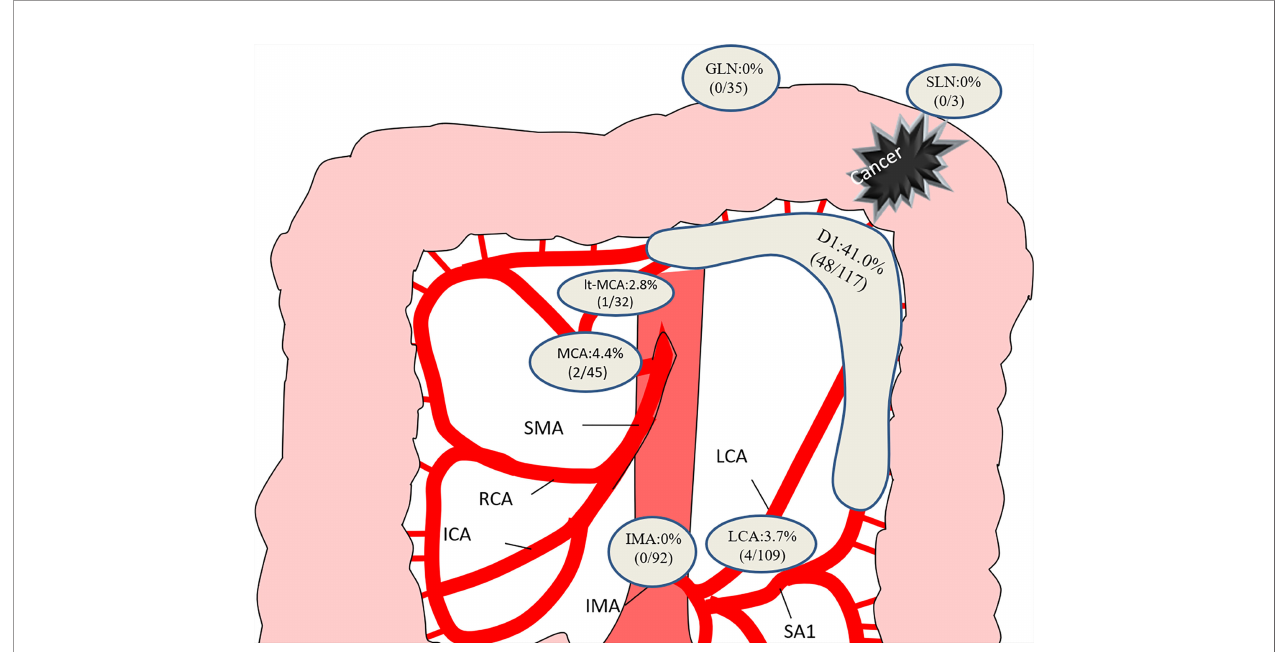
FIGURE 1 | Distribution of lymph node metastasis in the 117 patients. GLN, gastroepiploic lymph node; SLN, splenic hilar lymph node; MCA, middle colic artery; LCA, left colic artery; IMA, inferior mesenteric